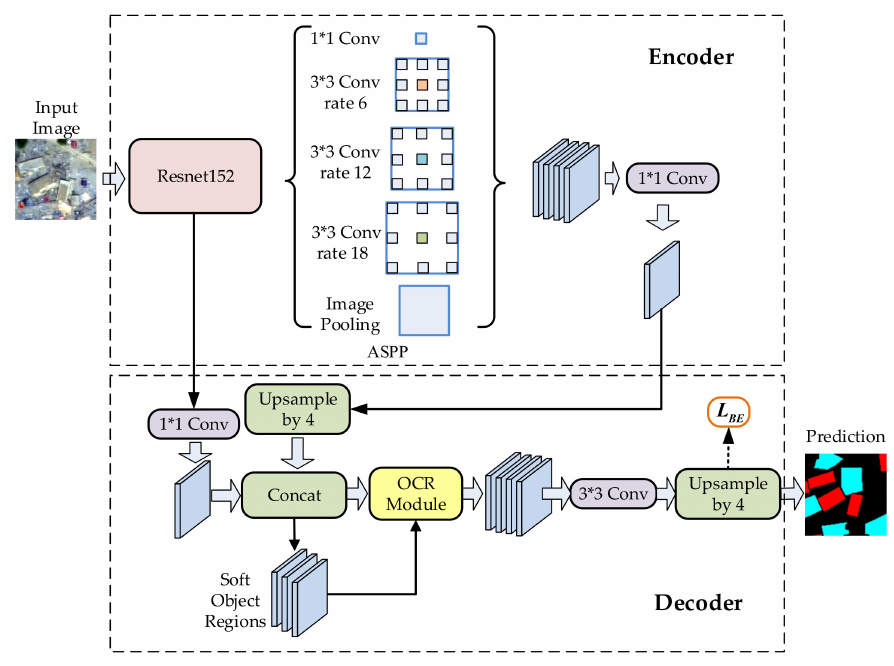
Figure 2. Overall structure of the proposed